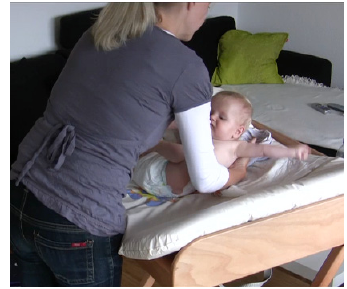
Figure 2. Mother accompanying the lifting movement of the infants’ body with her utterance.